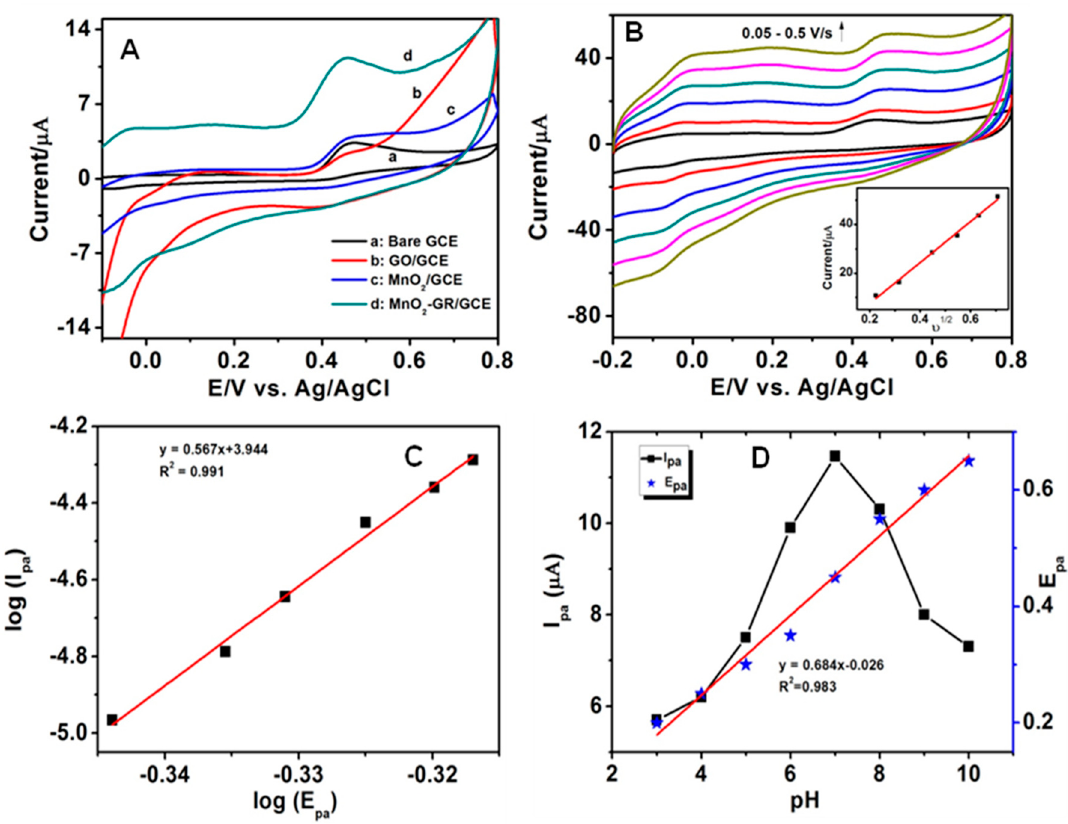
Figure 5. ( A ) CVs of (a) bare GCE, ( b ) GO/GCE, ( c ) MnO 2 /GCE and ( d ) MnO 2 -GR modified GCE in 100 µM SE; ( B ) CVs of MnO 2 -GR/GCE in the presence of SE at scan rates of 50–500 mV/s ( C ) log E pa vs. log I pa and ( D ) pH effect on the anodic peak current and peak potential of SE.